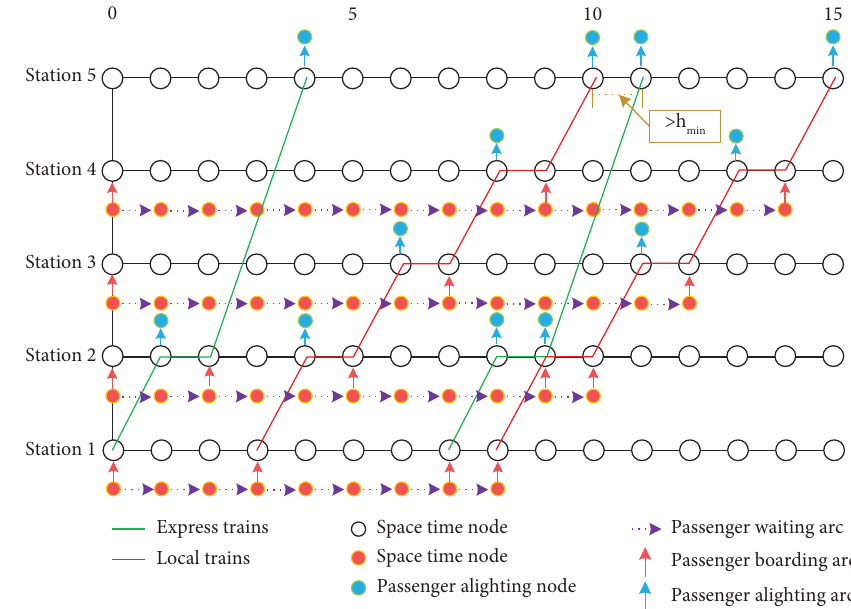
Figure 5: Te operation scheme of express and local mode.